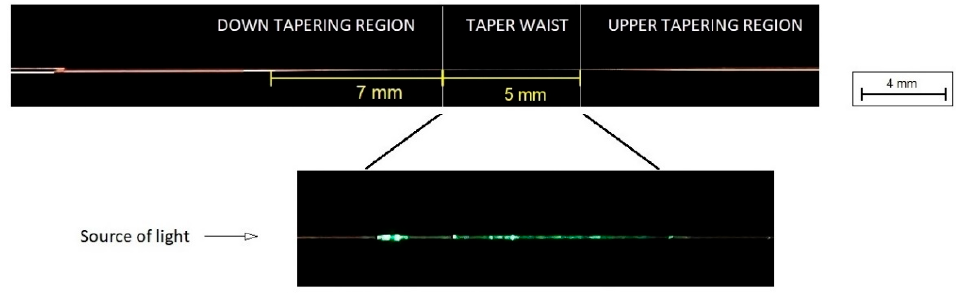
Figure 6. Tapered Optical Fiber—manufactured on FOTET.